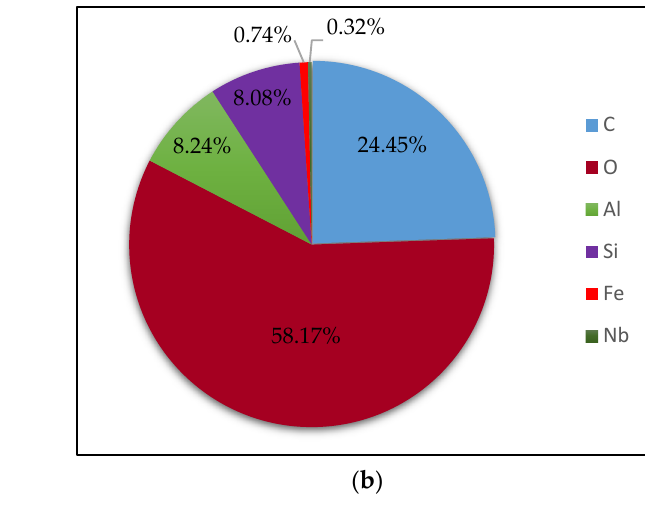
Figure 6. Characterization of minerals and compounds; ( a ) XRD analysis of Alevoor sample; ( b ) quantification of compounds.